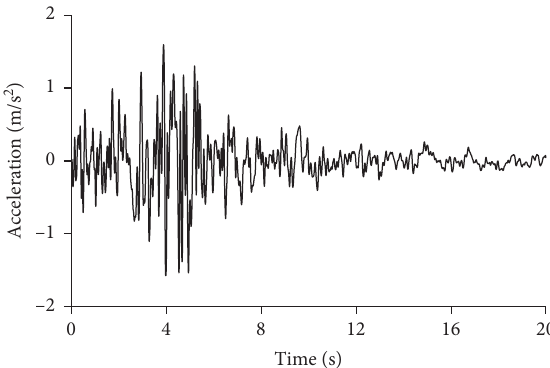
Figure 3: Acceleration time-history curve of input wave.